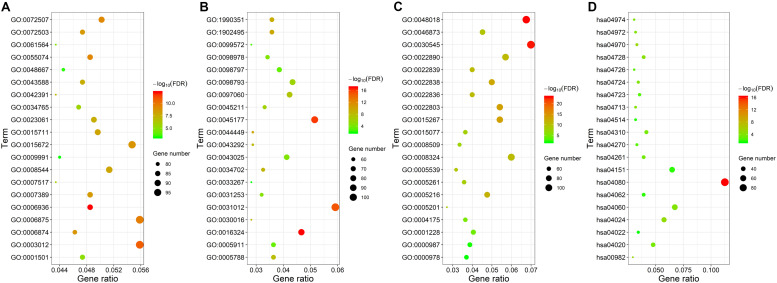
Gene ontology and KEGG pathway functional enrichment analyses of the differentially expressed mRNAs (DEmRNAs). (A) The biological function category of GO classification. (B) The cell component category of GO classification. (C) The molecular function category of GO classification. (D) KEGG pathway functional classification and annotation.